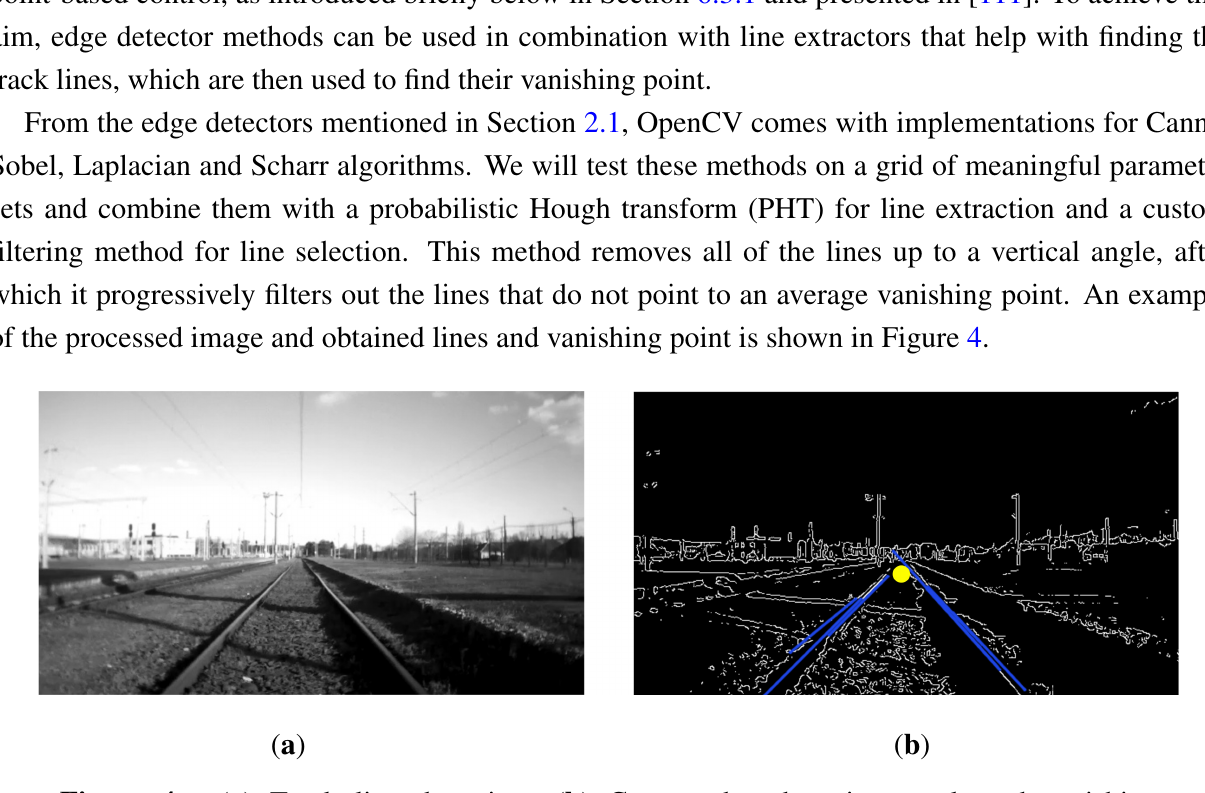
( a ) Track line detection; ( b ) Canny edge detection result and vanishing point